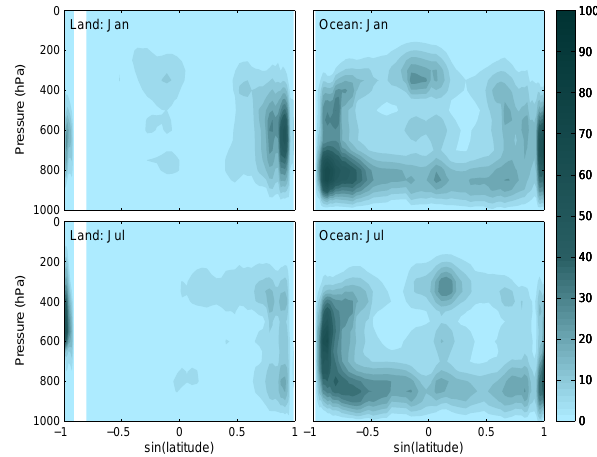
Fig. 2. Average cloud fraction with altitude following Rossow et al. (2005, and W. Rossow, personal communication, 2009), for January and July, land and ocean. White areas are where there is either no land (the Southern and Arctic Oceans) or no ocean